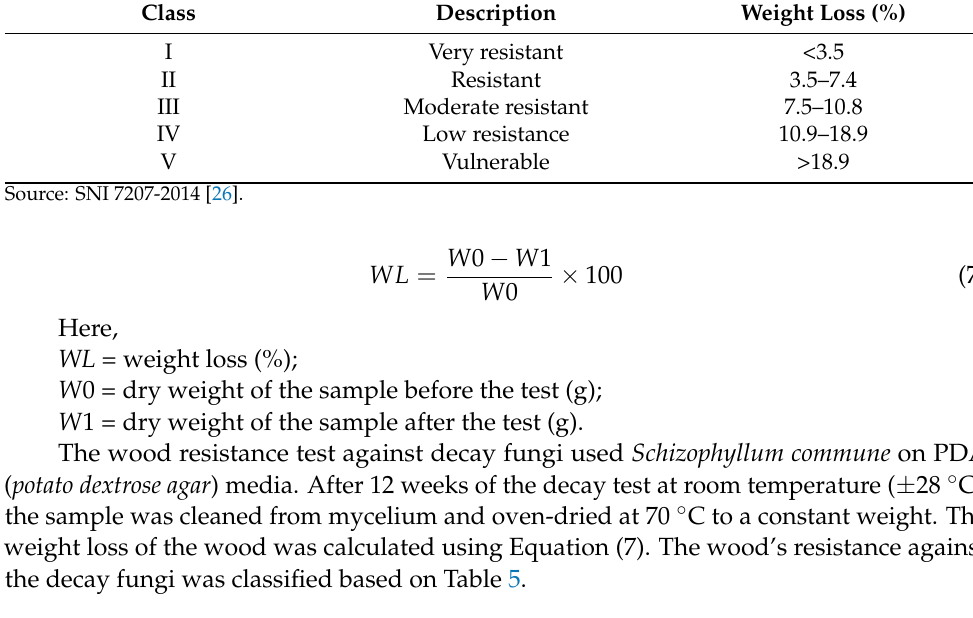
Table 5. Wood’s resistance against decay